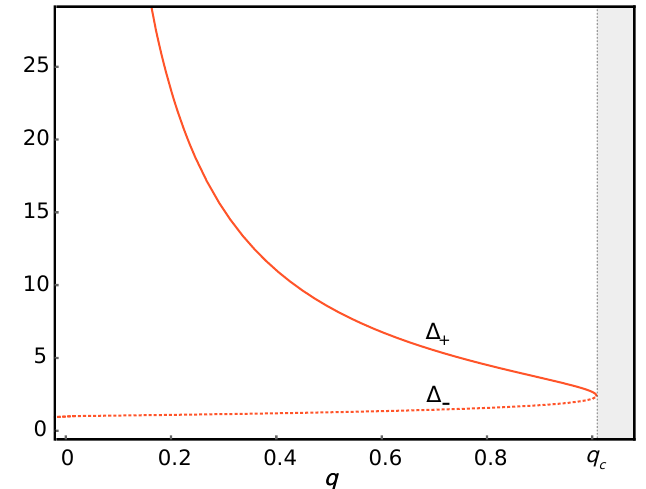
Figure 2 . Exponents ∆ ± as a function of the backreaction parameter q , given by eq. (4.6). The upper (solid) line is to the ∆ + curve, while the lower (dotted) one corresponds to the ∆ − . As before, the gray region corresponds to values q > q c for which the Lifshitz solution is